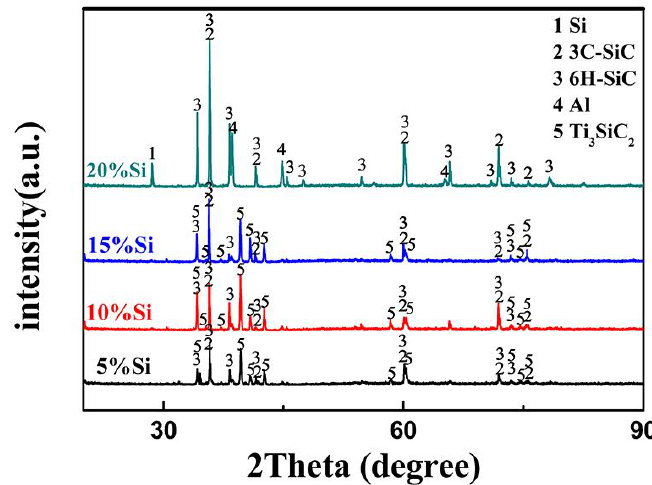
Figure 3. X-ray diffraction (XRD) pattern of the surfaces of the SiC ceramic. Table 1. Volume fraction (vol.%) of surface phase.